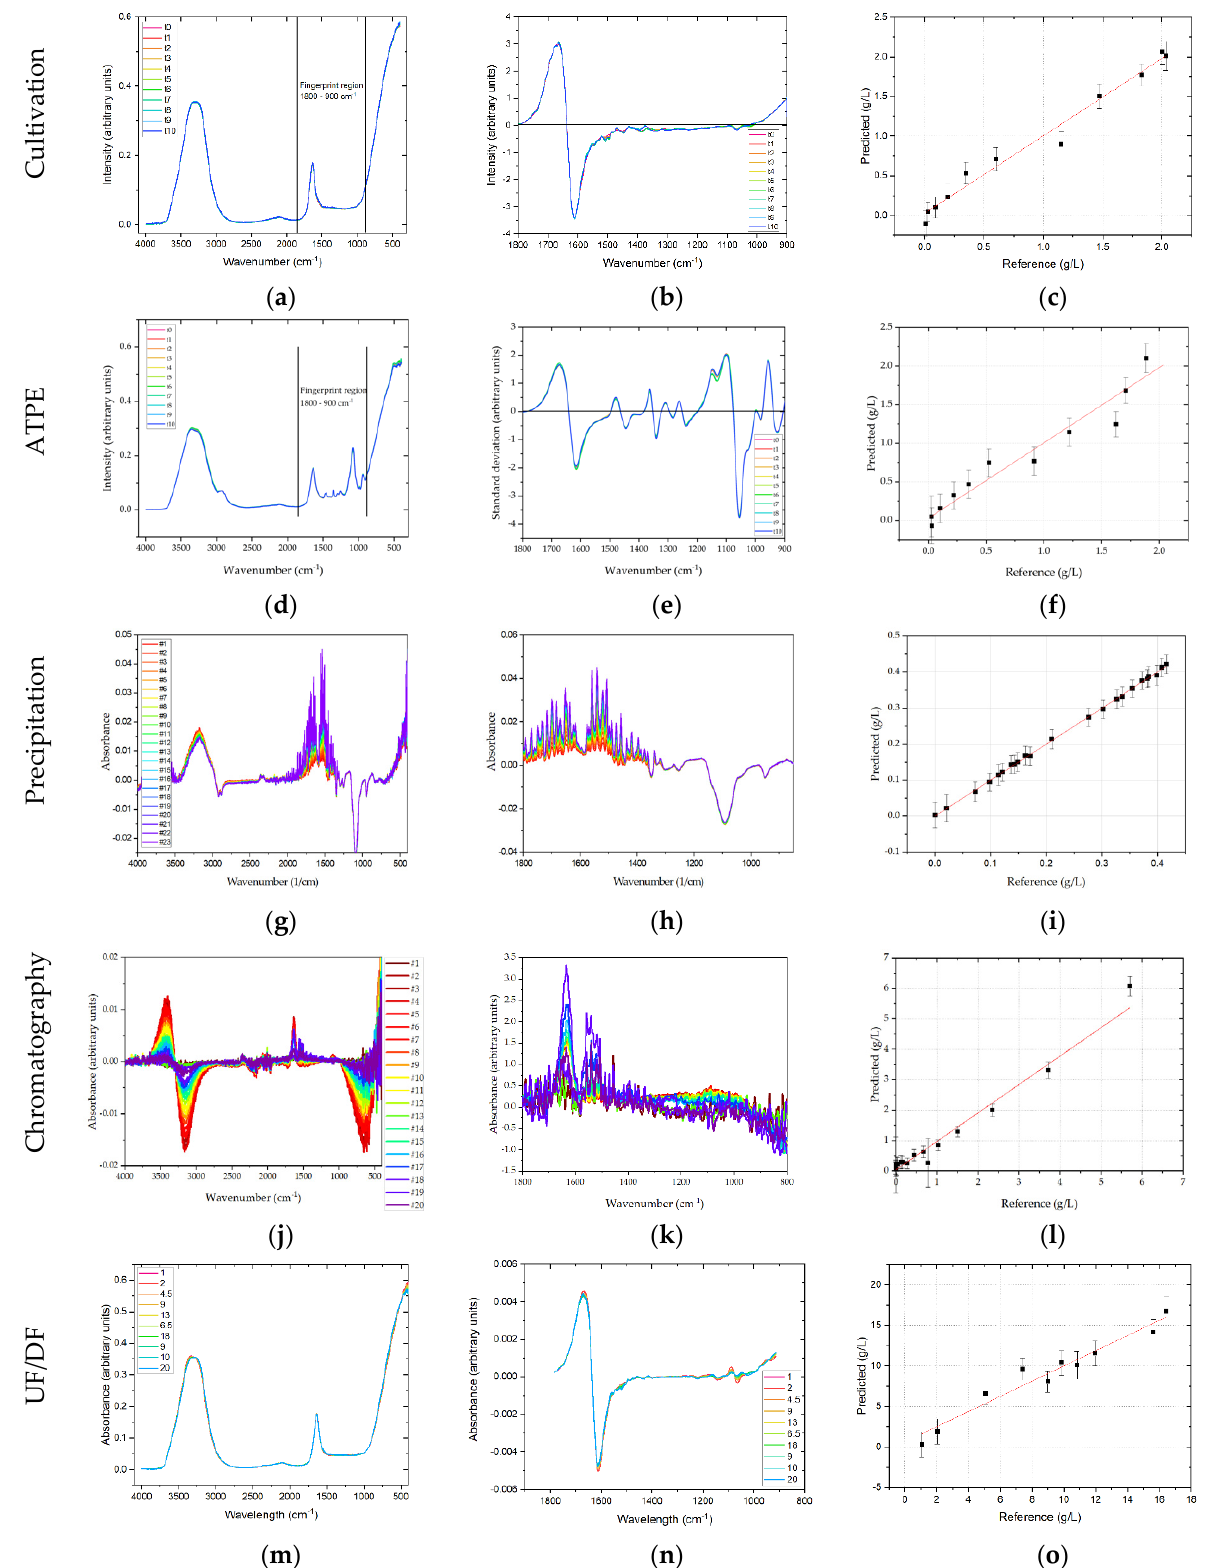
Figure 9. FTIR spectra: raw ( a , d , g , j , m ), after preprocessing ( b , e , h , k , n ) and PLSR results ( c , f , i , l , o ). Spectra are color-coded from high concentration (blue) to low concentration (red).